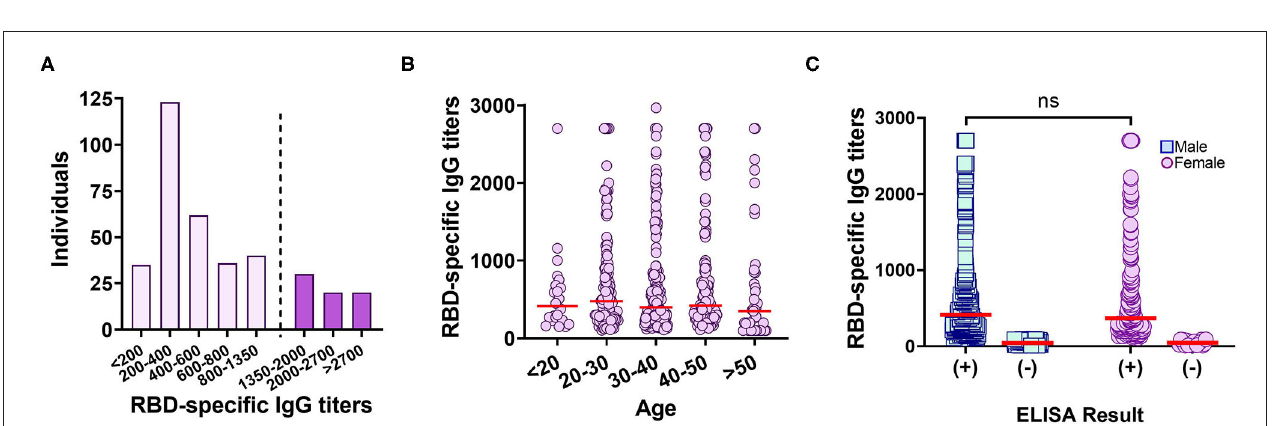
FIGURE 3 | Anti-RBD IgG titers measured by an “ In-House ” ELISA in the studied population. (A) Distribution of anti-RBD titers among 366 true positive samples. Dotted line delimits the population that correlates with a probability ≥ 80% of having neutralizing titers ≥ 160 (13). (B) Distribution of anti-RBD titers segregated into age groups. Red line: median. (C) Distribution of anti-RBD titers, for each gender, measured by the anti-RBD “ In-House ” ELISA. Red line: median. ns, p = 0.4940, Kolmogorov–Smirnov test.